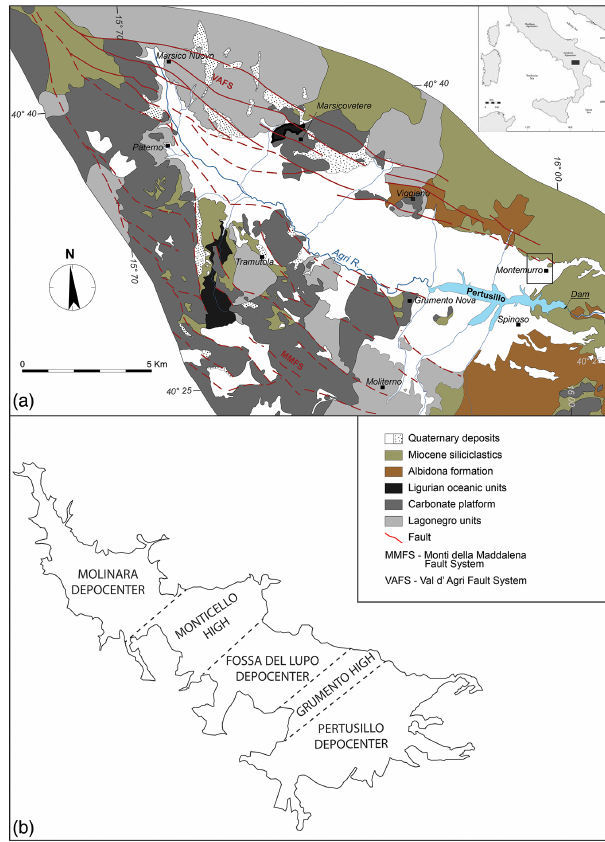
Figure 2. Geological sketch map of the Val d’Agri Basin (modified from Giocoli et al., 2015). Dashed black lines indicate the limits between highs and